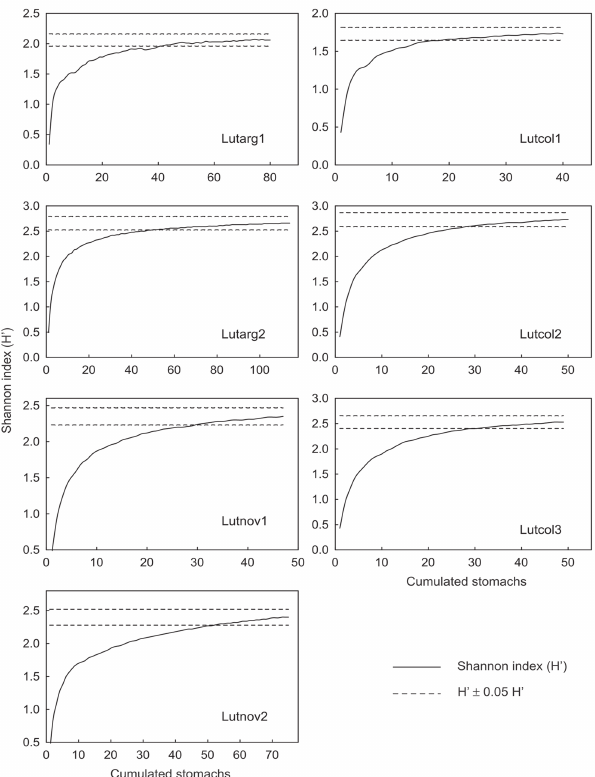
Fig. 4. Cumulative curves of food items. Lutarg: Lutjanus argentiventris ; Lutcol: Lutjanus colorado ; Lutnov: Lutjanus novemfasciatus. Numbers indicate size classes: 1 for LT < 7 cm; 2 for LT ≥ 7 cm and LT < 21 cm; 3 for LT ≥ 21 cm.